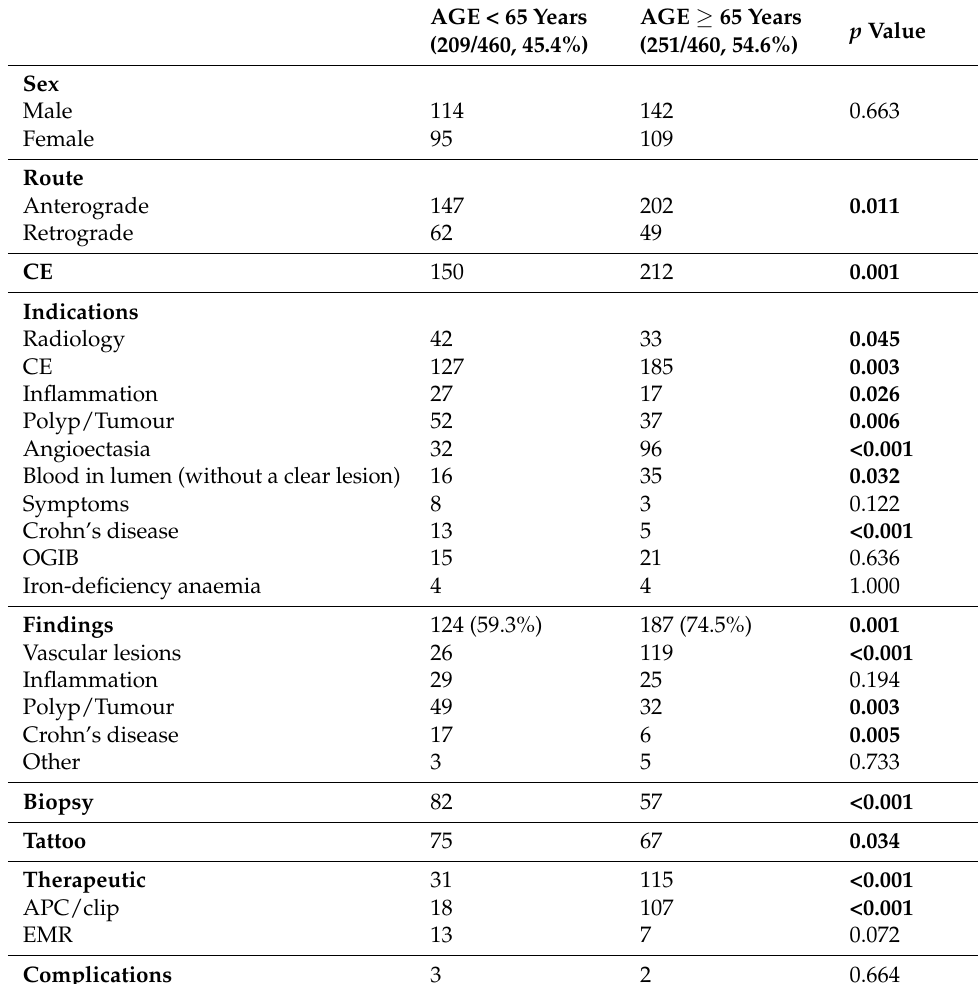
Table 2. Comparison between adult and elderly patients: characteristics, indications, diagnostic and therapeutic yield, and adverse